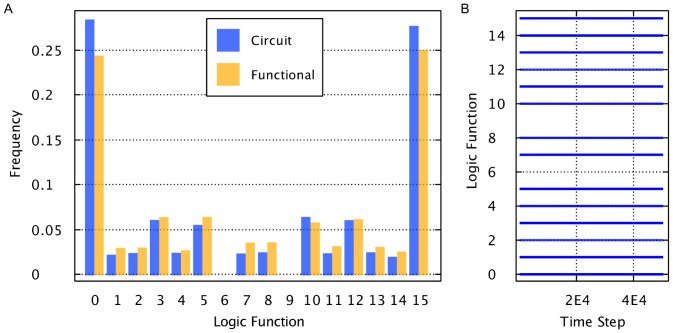
AHaH attractor states as logic functions.A) Logic state occupation frequency after 5000 time steps for both functional model and circuit model. All logic functions can be attained directly from attractor states except for XOR functions, which can be attained via multi-stage circuits. B) The logic functions are stable over time for both functional model and circuit model, indicating stable attractor dynamics.